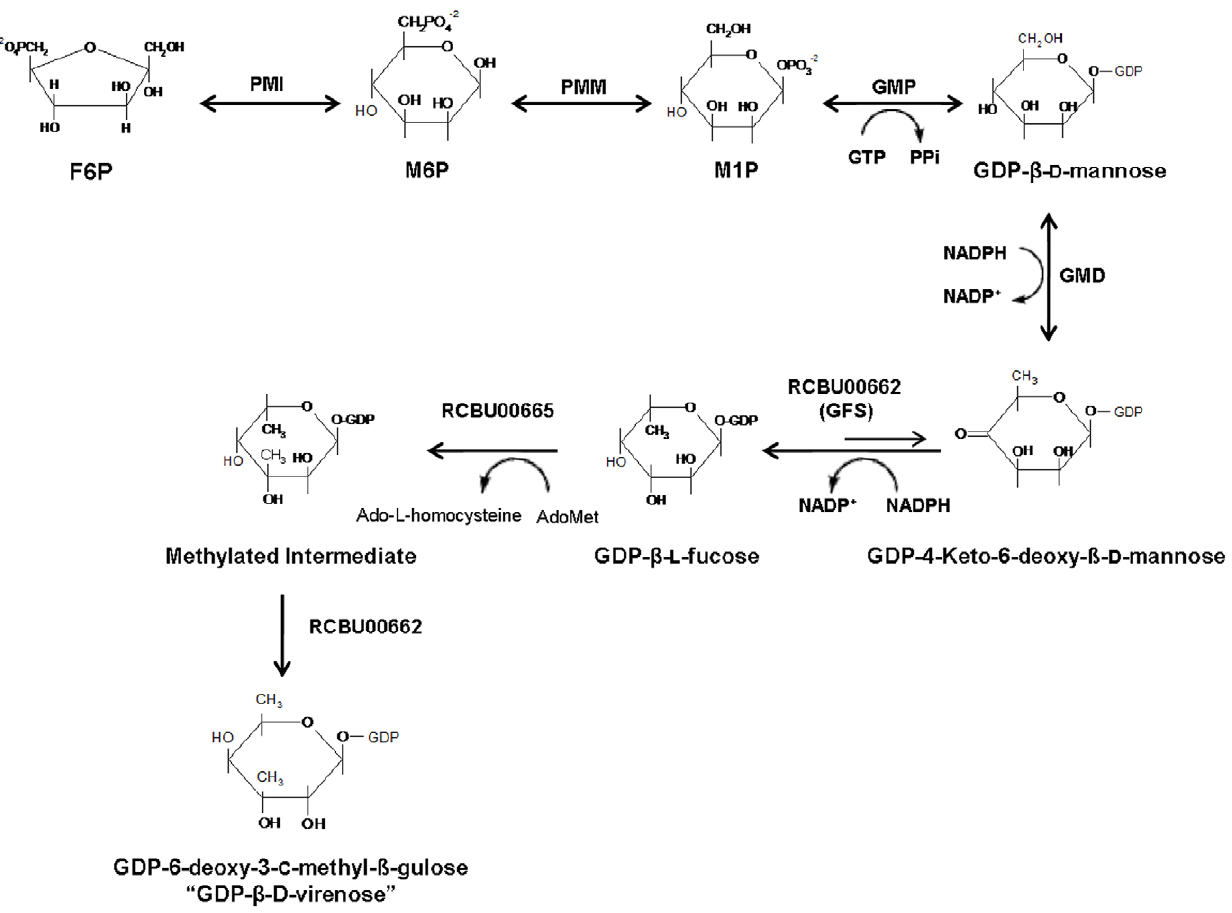
Figure 1. Putative GDP- b -D-virenose biosynthesis pathway. 1. F6P, fructose-6-phosphate; PMI, phosphomannose isomerase 2. M6P, mannose-6-phosphate; PMM, phosphomannomutase 3. M1P, mannose-1-phosphate, GMP, GDP-mannose pyrophosphorylase 4. GMD, GDP-mannose 4,6-dehydratase; NADP + nicotinamide adenine dinucleotide phosphate 5. GFS, fucose synthase 6. Ado-Met, S-adenosyl methionine.